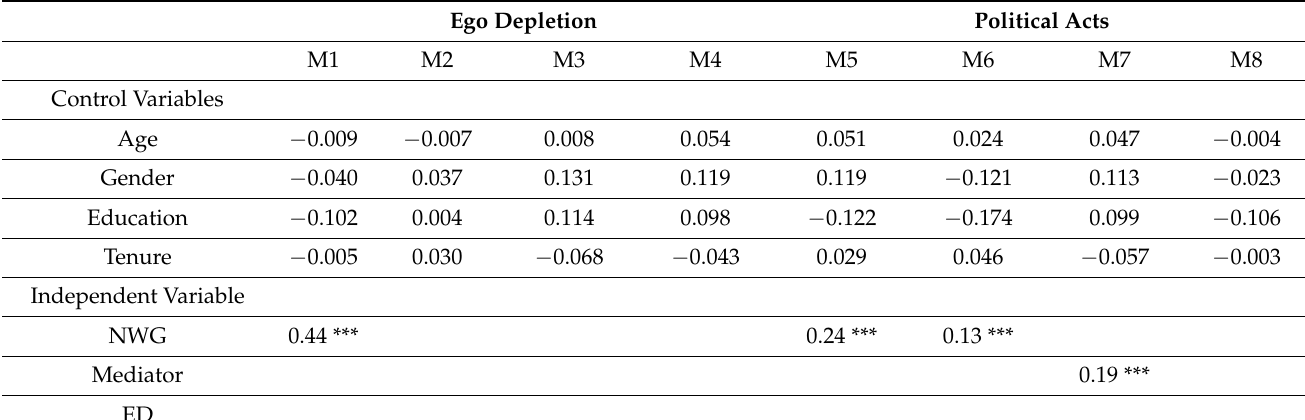
Table 4. Results of hierarchical regression analyses ( n =